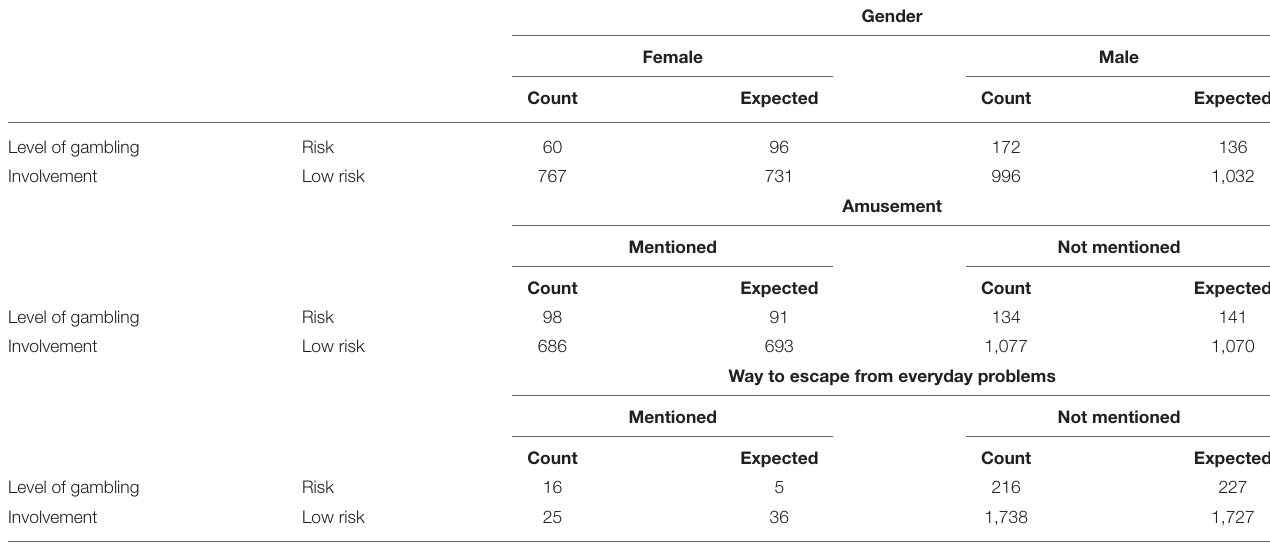
TABLE 3 | Level of gambling involvement based on gender and gambling motives.